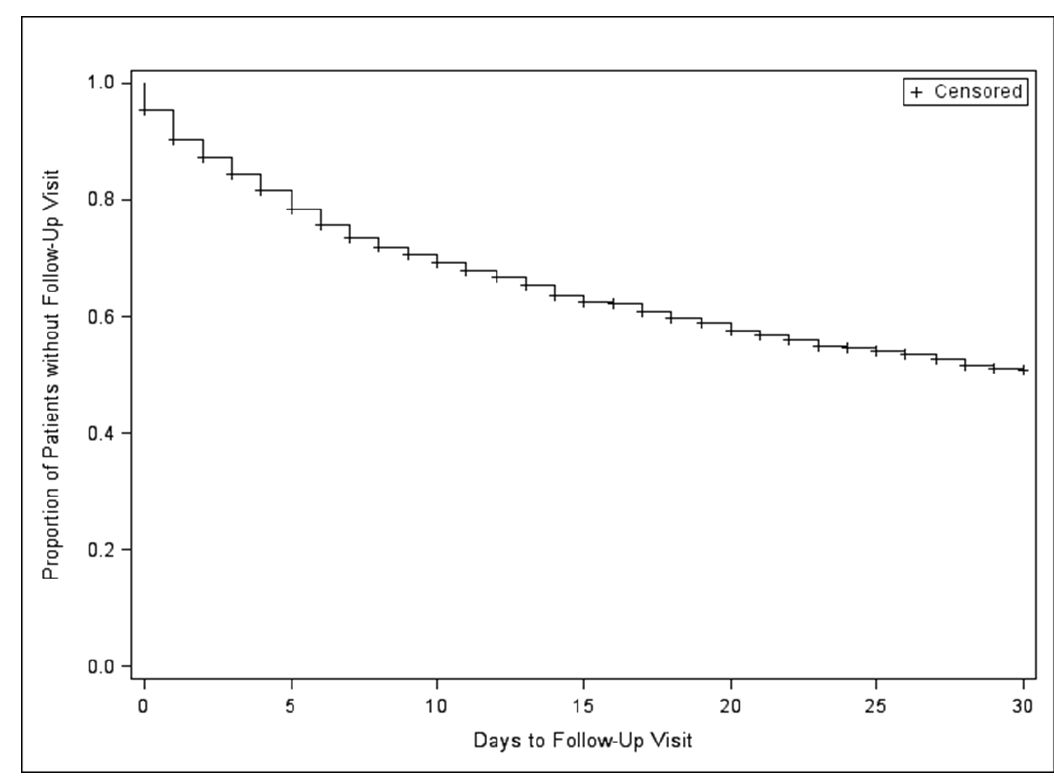
Figure 1. Kaplan-Meier Curve for Time to Follow-up Visit